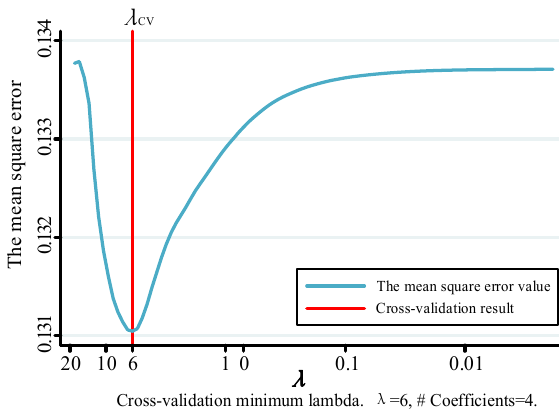
Figure 5. Cross ‐ validation effect chart.